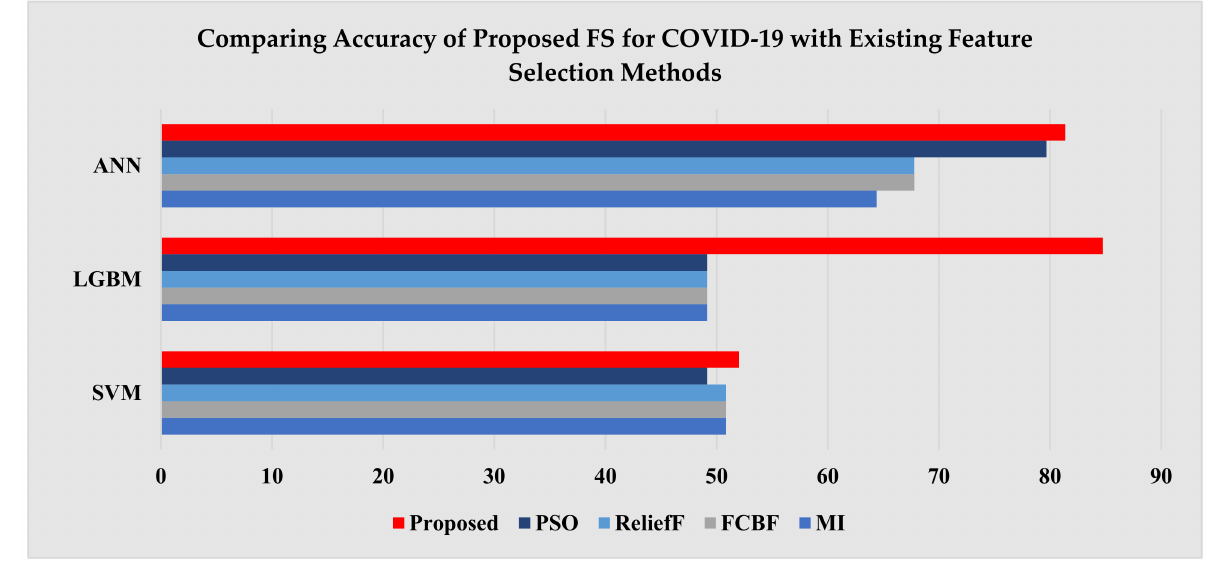
Figure 3. Accuracy Comparison of Proposed FS for Teachers Satisfaction in COVID-19 with Existing Feature Selection Methods.